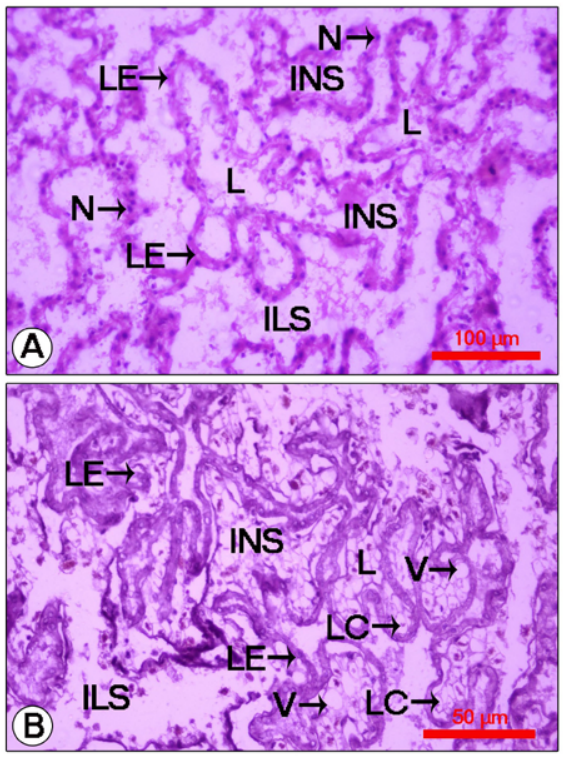
Figure 12. Light micrograph of Y-organ of crabs treated with MF during early postmoult in Travancoriana schirnerae . ( A ) Medium sized, loosely arranged, branched lobules with intra and inter- lobular spaces and lobular epithelial cells with pycnotic nuclei. ( B ) Thin lobular epithelium and a few intact cells in the lobules. ILS: Inter-lobular space; INS: Intra-lobular space; L: Lobule; LC: Larger cell; LE: Lobular epithelium; N: Pycnotic nuclei; V: